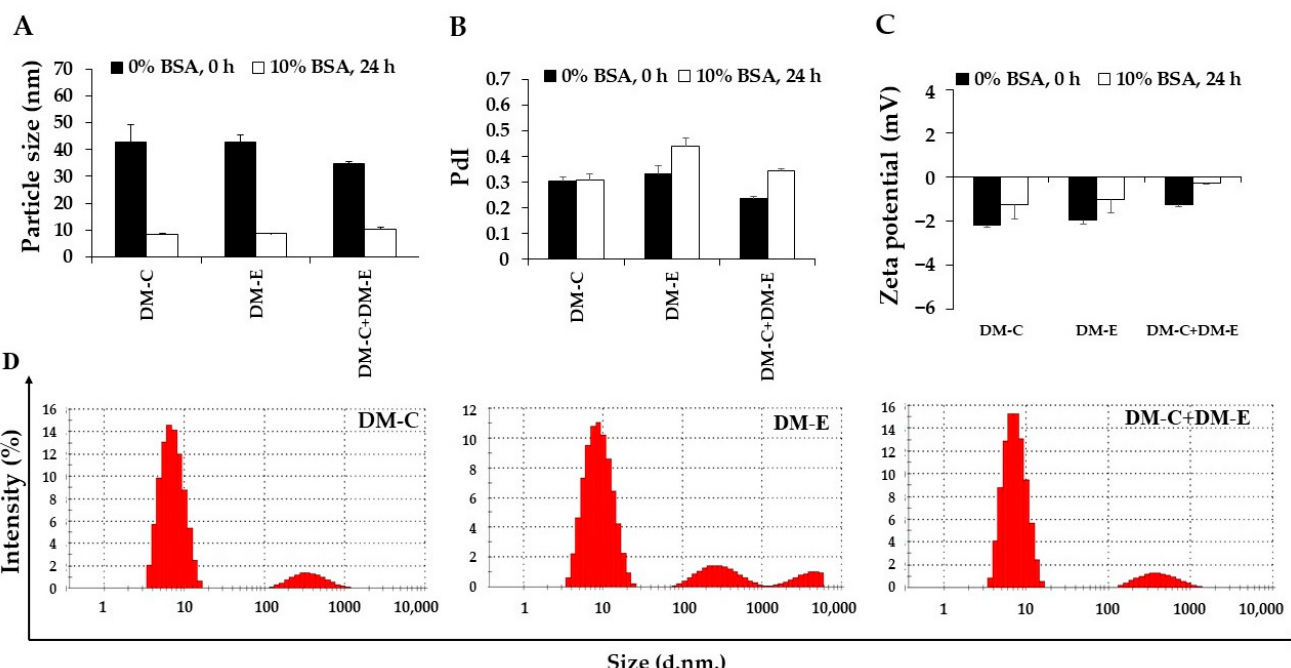
Figure 10. The alterations in ( A ) particle size, ( B ) polydispersity index (PdI), ( C ) zeta potential value, and ( D ) particle size distribution of Dox-micelle conjugated FLT3 peptides, including DM-CKR (DM-C), DM-EVQ (DM-E), and DM-CKR+DM-EVQ (DM-C+DM-E) after 24 h of incubation in PBS, pH 7.4 containing 10% BSA at 37 ◦ C in the dark. The data were shown as mean ± SE ( n =